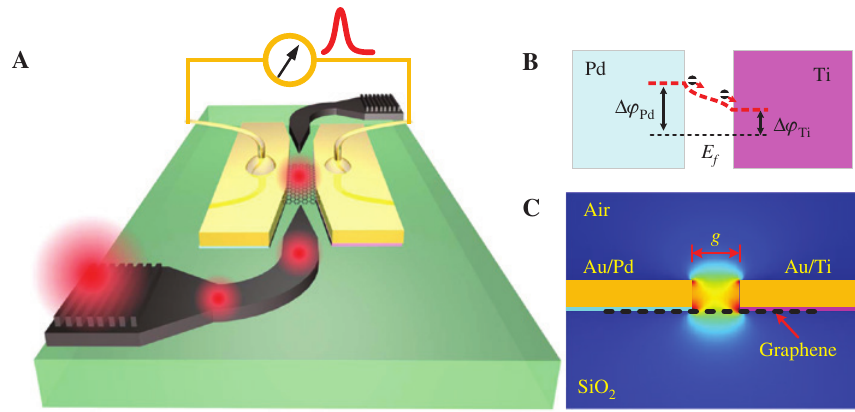
Figure 1: Principle of the graphene-plasmonic integrated photodetector. (A) Schematic of the proposed graphene-plasmonic hybrid photodetector. (B) The potential profile of the device showing the drift of the photogenerated carrier. Δ φ and Δ φ are the difference between the Dirac point energy and the Fermi level in palladium- and titanium- Pd Ti doped graphene, respectively. (C) Cross-section of the device with its corresponding plasmonic slot mode at λ = 1.55 μ